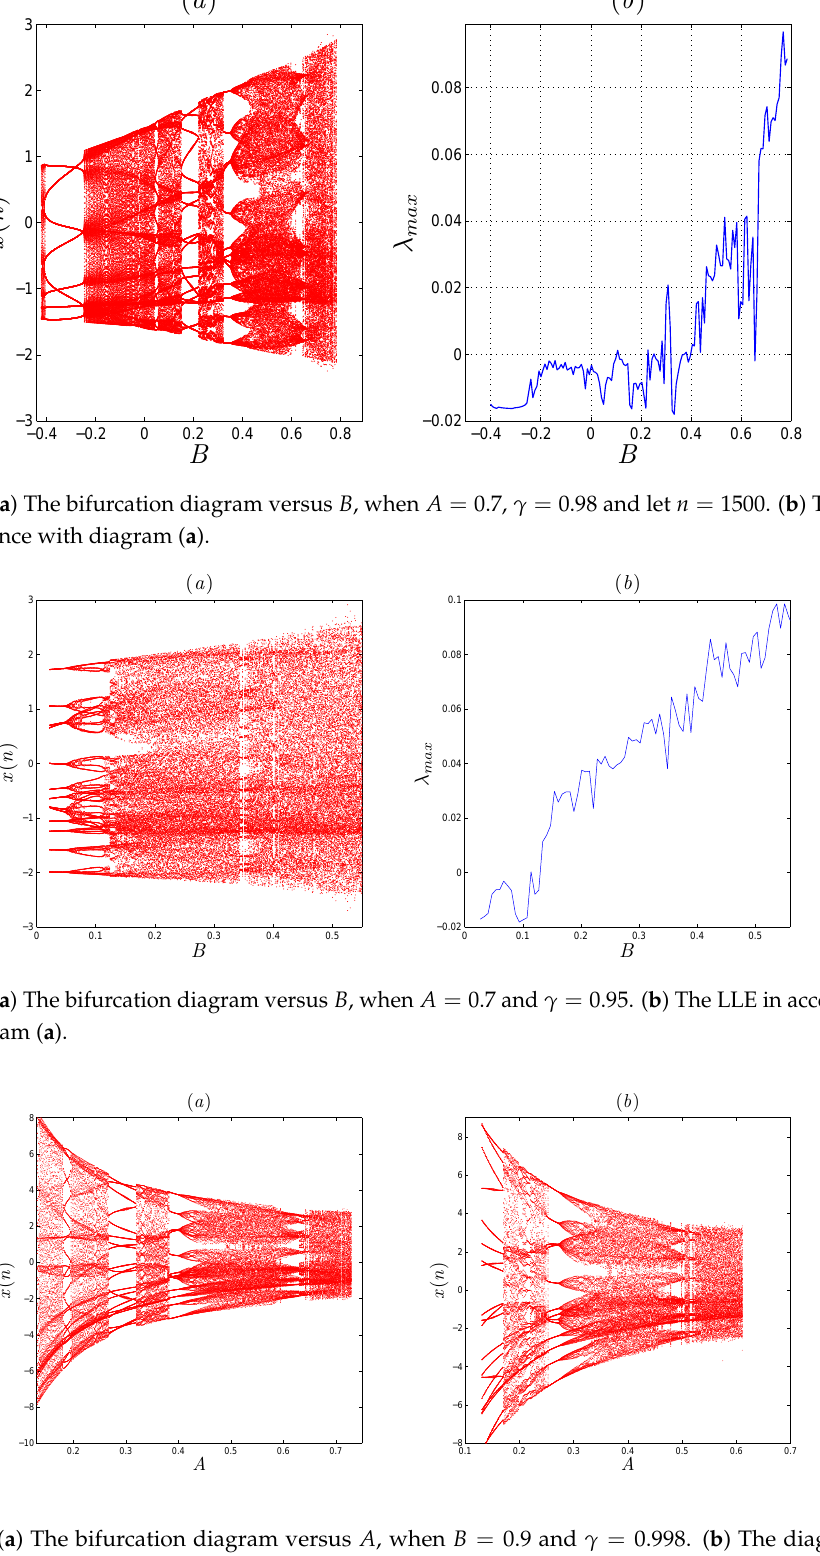
Figure 5. ( a ) The bifurcation diagram versus A , when B = 0.9 and γ = 0.998. ( b ) The diagram of bifurcation versus A , when B = 0.9 and γ =